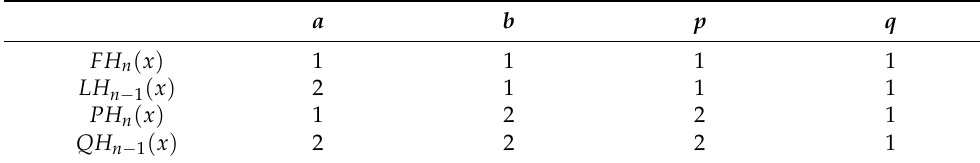
Table 4. Some special cases for H n ( x )